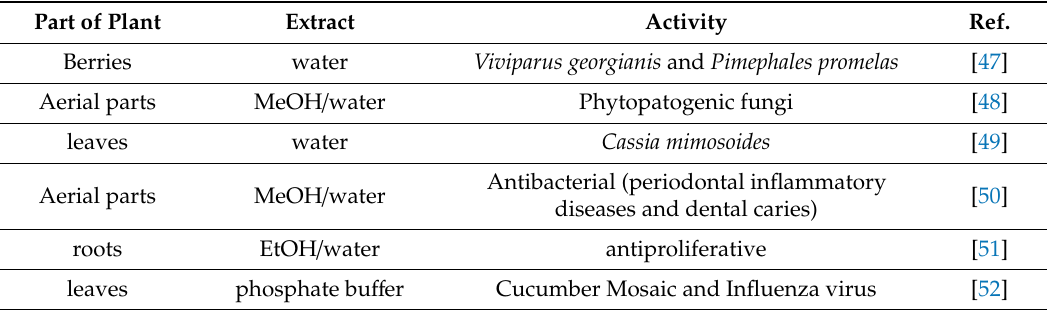
Table 3. Biological activity of extracts of Phytolacca americana.